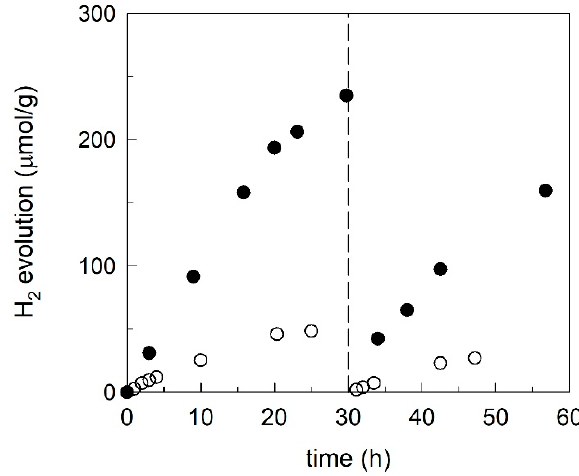
Figure 5. Conduction (unfilled) and valence (shaded) band positions for several simple perovskites with octahedral Ta 5+ , as deduced from diffuse reflection absorbance and XPS measurements.